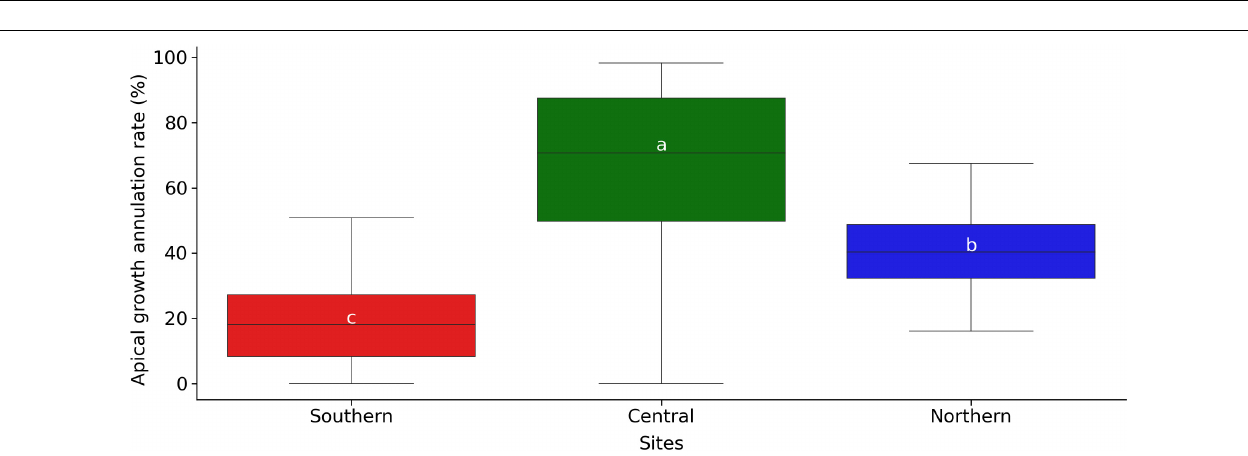
FIGURE 7 | Relationships between the proportion of severely damaged trees by the late-spring frost of 2021 and (A) tree height before the late-spring frost event and (B) frost intensity.